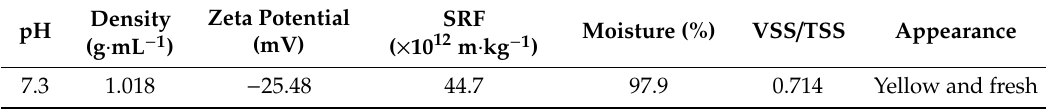
Table 1. The details of the active sludge used in the